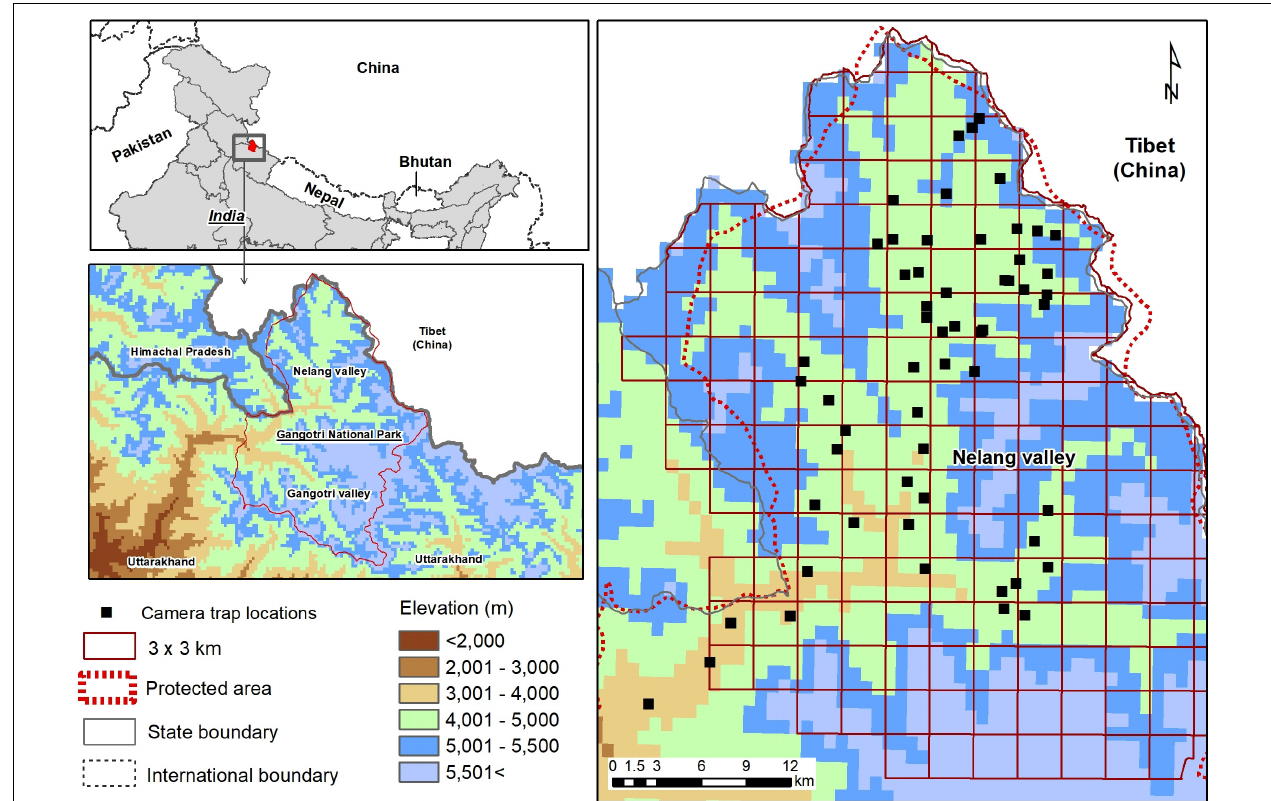
FIGURE 1 | Locations of camera traps in the Nelang valley of the Gangotri National Park, Uttarakhand, India.